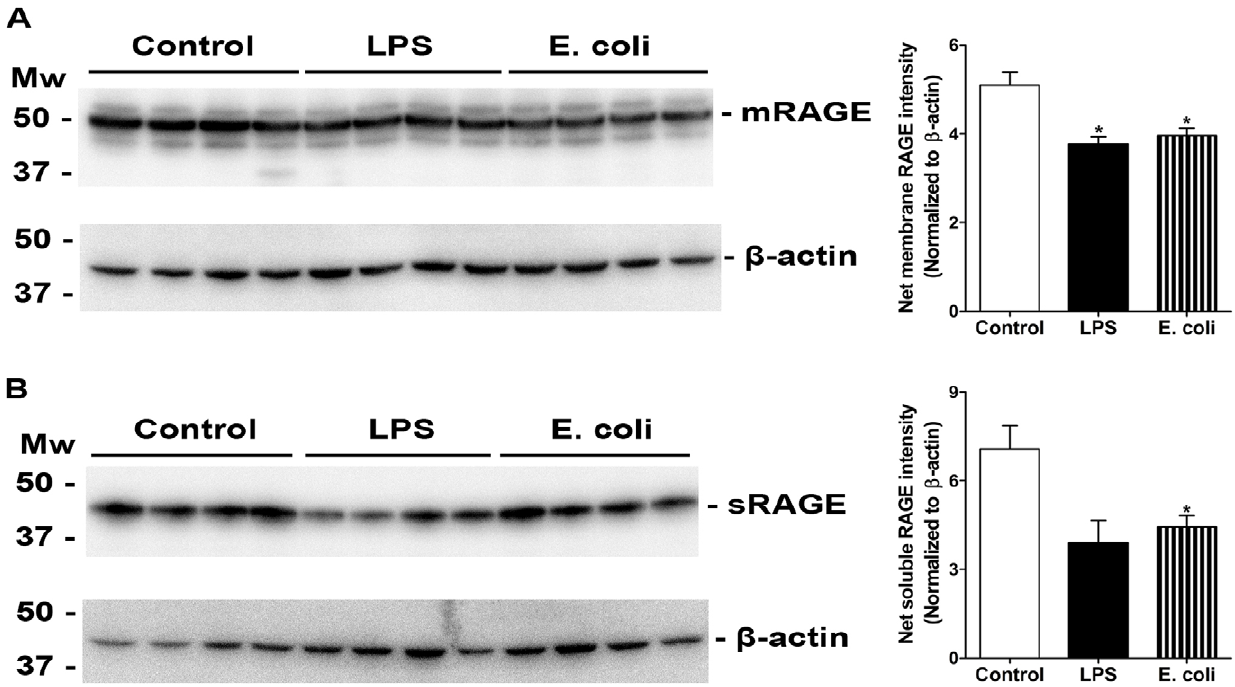
Figure 4. RAGE protein levels are decreased in the lungs after injury. Aliquots of 10 m g of protein from membrane or soluble protein fractions from lung homogenates were assayed for RAGE expression by western blot analysis of RAGE and b -actin. Net intensity of RAGE expression was normalized to b -actin. Membrane RAGE expression was significantly decreased after both LPS and E. coli challenge (A). Soluble RAGE expression was significantly decreased after E. coli injury, and markedly, but not significantly decreased after LPS injury (p=0.057 for LPS treatment). Normalized net intensities were analyzed by a Mann-Whitney test. (* p , 0.05, n of 4 mice per group ).